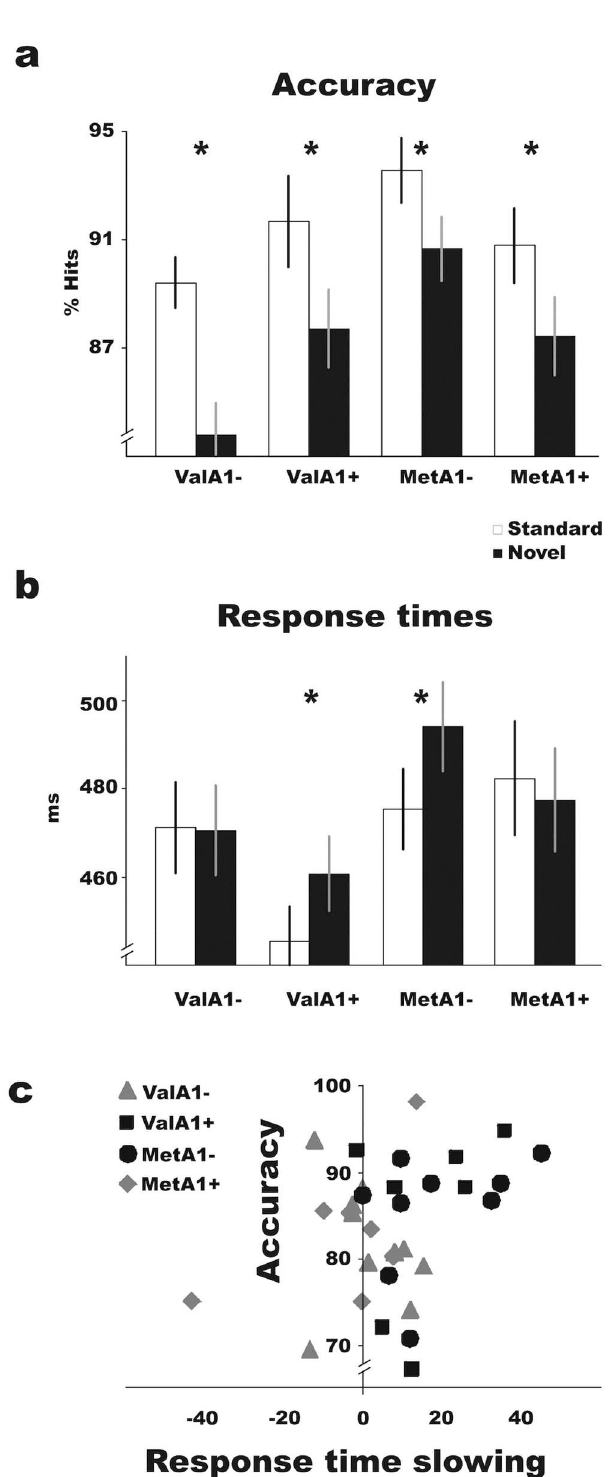
Fig 1. Task performance in all four groups. ( a ) Accuracy was lower in trials with novel sounds in comparisonto those with standard sounds in all four groups ( * , p < 0.005).Notice the inverted-U shapeof accuracyin the two trial types for the four groupsarrangedin the panel accordingto their levels of PFC-Striatum DA balance. ( b ) Response times in standard and novel trials ( * , p < 0.03).Notice that two groups displayedsimilar RT (i.e., ValA1- and MetA1+) in standardand novel trials, whereasthe other two groups